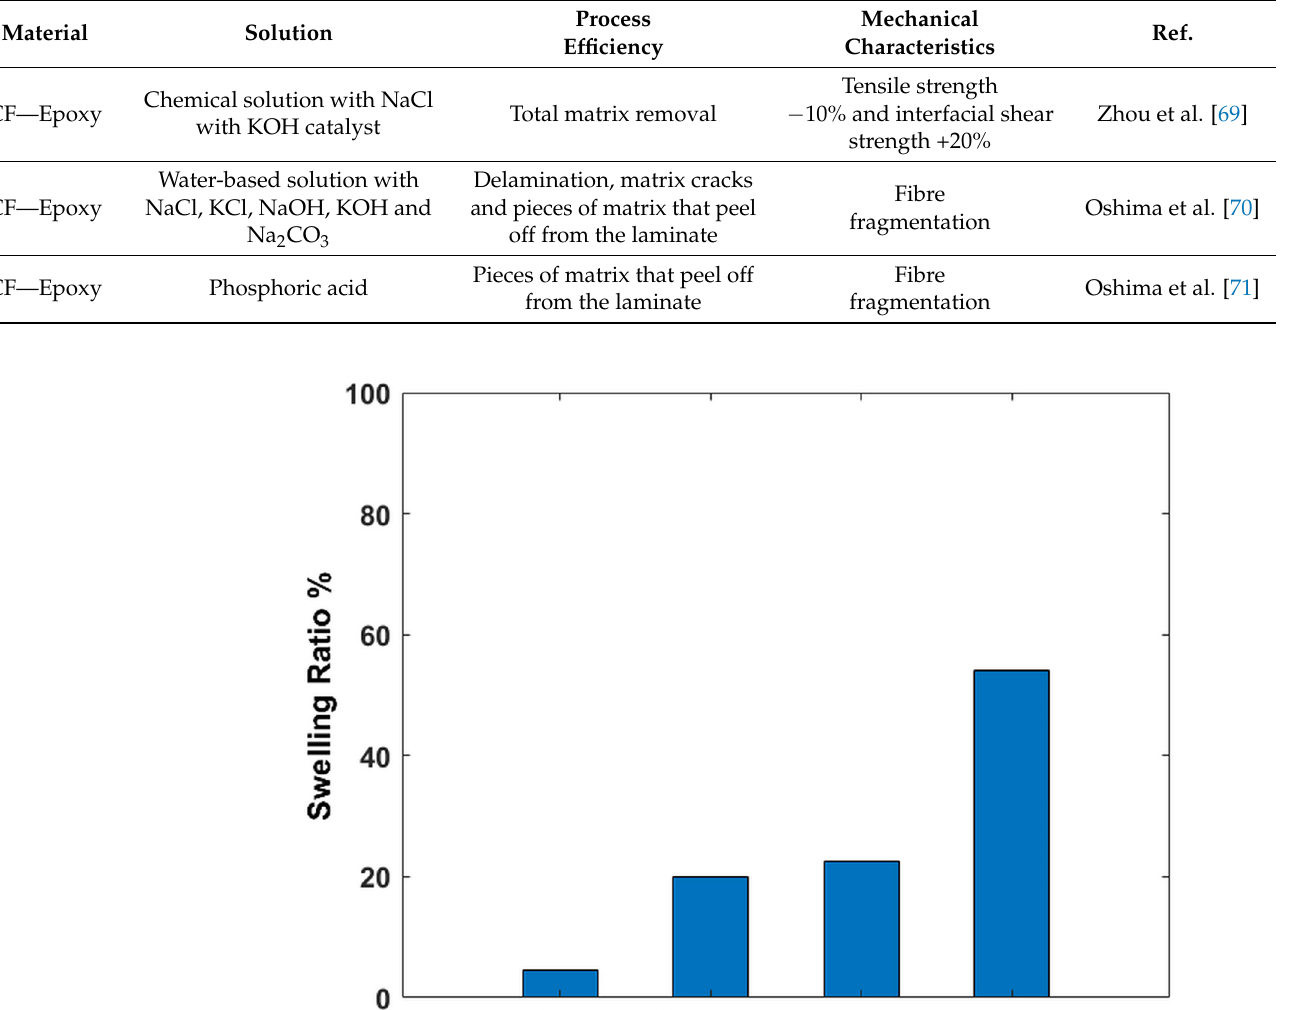
Table 2. Main results deriving from the electrochemical recycling method.